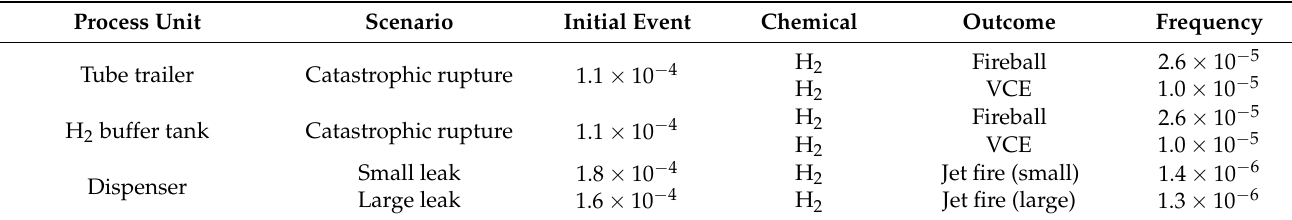
Table 4. Frequency analysis results for the GHRS